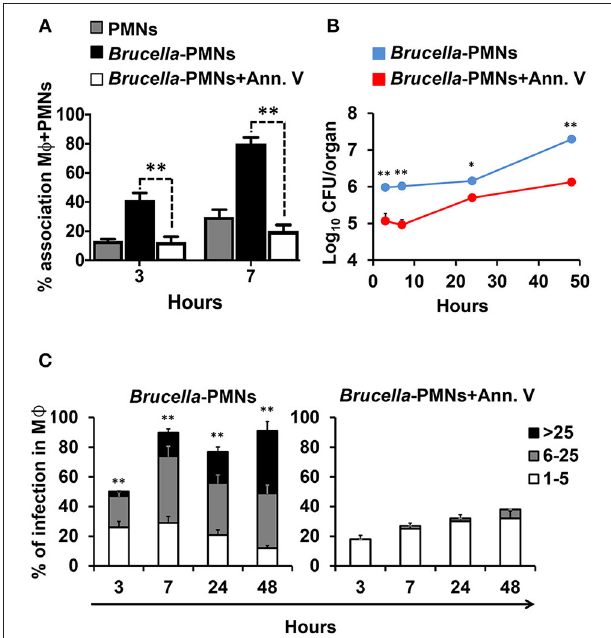
FIGURE 6 | Blockage of PS on the surface of Brucella- infected PMNs hampers M φ B. abortus infection. (A) B. abortus infected PMNs were pre-treated or not with Annexin V before co-incubation with RAW M φ s, and cell association estimated. The red dashed line corresponds to the mean value of non-infected PMNs (B) B. abortus infected PMNs (MOI 5) were pre-treated or not with Annexin V before co-incubation with RAW M φ s and CFU determined at different time points. (C) B. abortus infected PMNs were pre-treated or not with Annexin V before co-incubation with RAW M φ s and the number of infected M φ s and intracellular bacteria within these cells estimated at different time points. Cells were stained (DAPI for nuclei; phalloidin-FITC for actin filaments), fixed and mounted with MOWIOL. At least 200 cells were counted in each experiment. The percentage of infection and the number of intracellular bacteria (1–5, 6–25, or > 25) per M φ was determined by fluorescence microscopy. Values of p < 0.05 (*) and p < 0.01 (**) are indicated in relation to M φ s incubated with PMNs treated with Annexin V. These experiments were repeated at least three